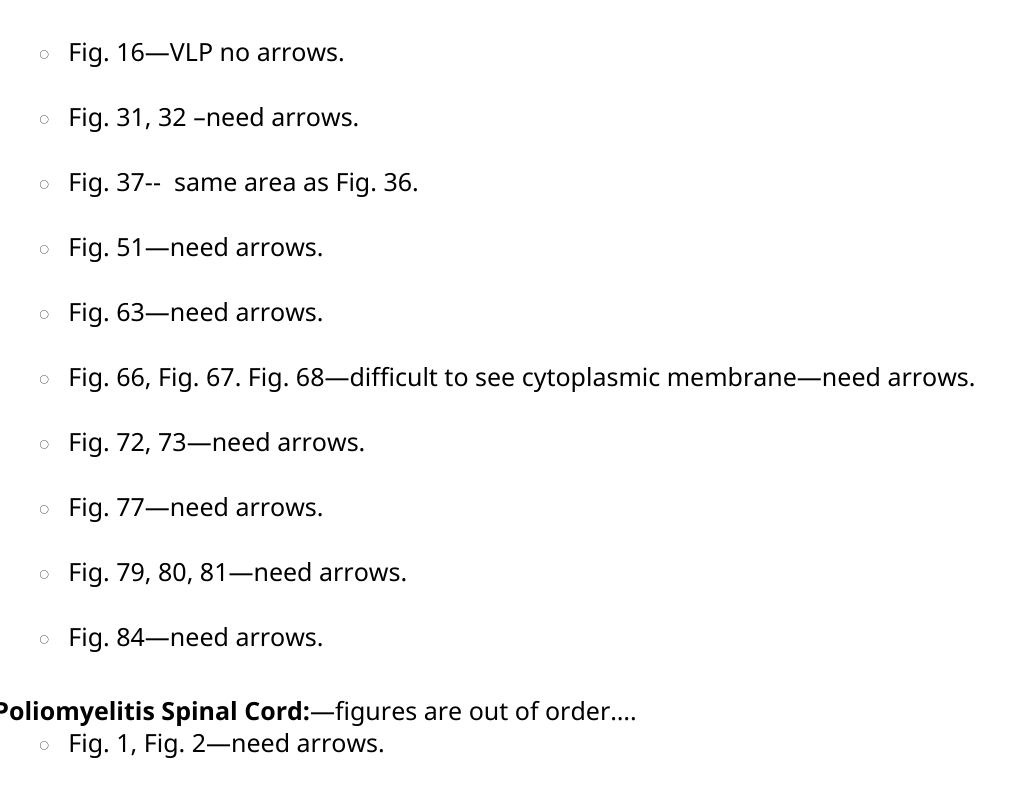
Fig. 6, 7, 8—need arrows. ○